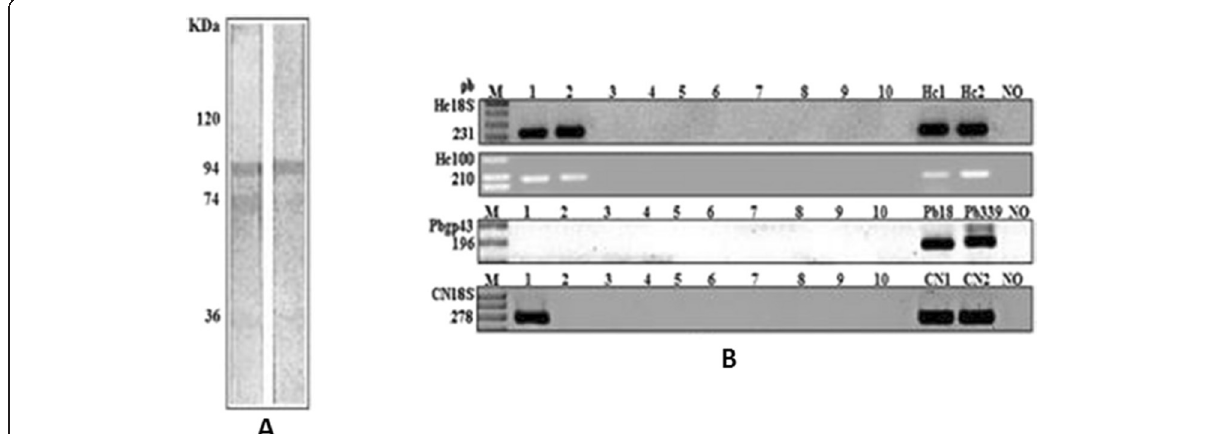
Figure 1 Immunoblotting and PCR assays. (A) : Immunoreactivity of serum patient against H and M fractions of H. capsulatum . (B) : Lane M. DNA molecular weight marker 1kb DNA ladder; Lane 1. patient serum collected in February 2008; Lane 2.- patient serum collected in June 2008; Lanes 3 to 10. negative individual sera samples, Lane Hc1. H. capsulatum strain (immunodeficiency); Lane Hc2. H. capsulatum 200 strain; Lane Pb 18. P. brasiliensis strain; Lane Pb 339 P. brasiliensis 339, Lane CN1 e CN2. C. neoformans strains (ATCC 24067) and Lane NO. negative